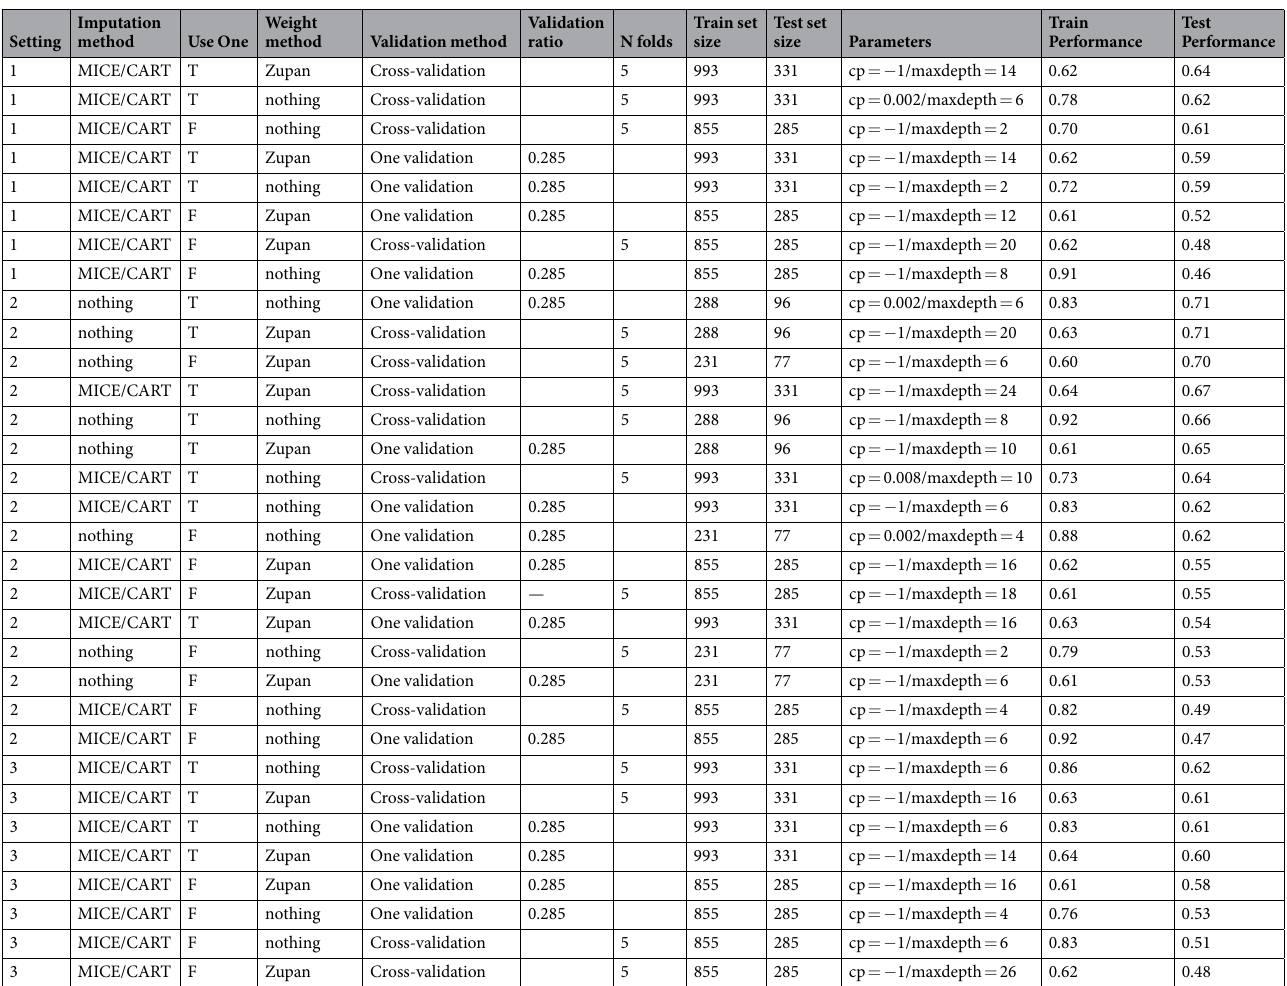
Table 3. Performance of the prediction model by conventional decision tree using different model setting. * Test performance were presented as concordance index for time to graft failure data. Model setting 1: Use overall attributes with multiple imputation. Model setting 2: Use attributes except DSA, with/without imputation. Model setting 3: Use attributes except 3 month follow up data, with imputation. Test ratio fixed at 0.3. Use One False (F) is used if the follow-up period is shorter than the period to be predicted in the classification; these cases were excluded from the training process. Use One True (T) is used as a positive example if the patient has experienced a graft failure even though the follow-up period is short. Weight method by Zupan et al . is used when the follow-up period is short, with both positive and negative examples used, but with different weights 6